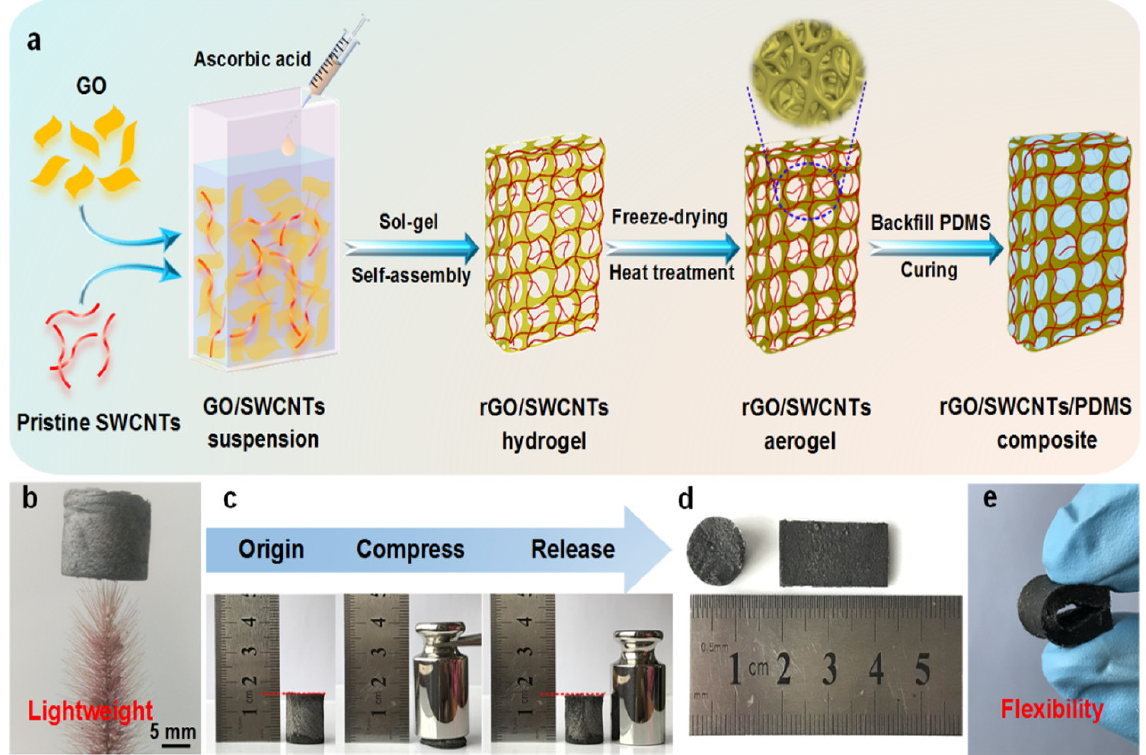
Figure 8. ( a ) Schematic depicting the fabrication of rGO/SWCNTs/PDMS aerogel. ( b ) Digital photo- graph of the ultralight aerogel. ( c ) A photograph of aerogels demonstrating excellent compressibility and super-elasticity. ( d , e ) Optical images of these aerogels in diverse shapes ( d ) and bending of aerogels demonstrating outstanding flexibility ( e ). Reproduced with permission from [108]. Copy- right 2018, American Chemical Society.